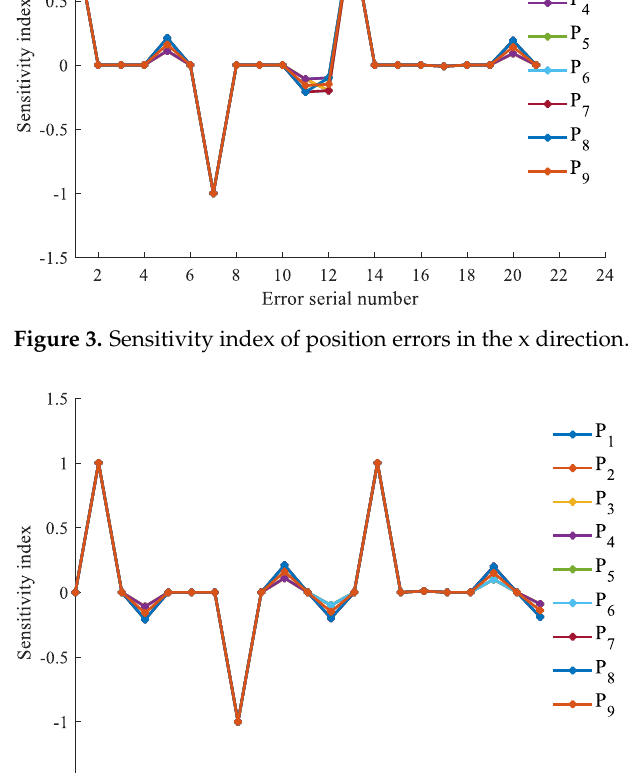
Figure 5. Sensitivity index of position error in the z direction.